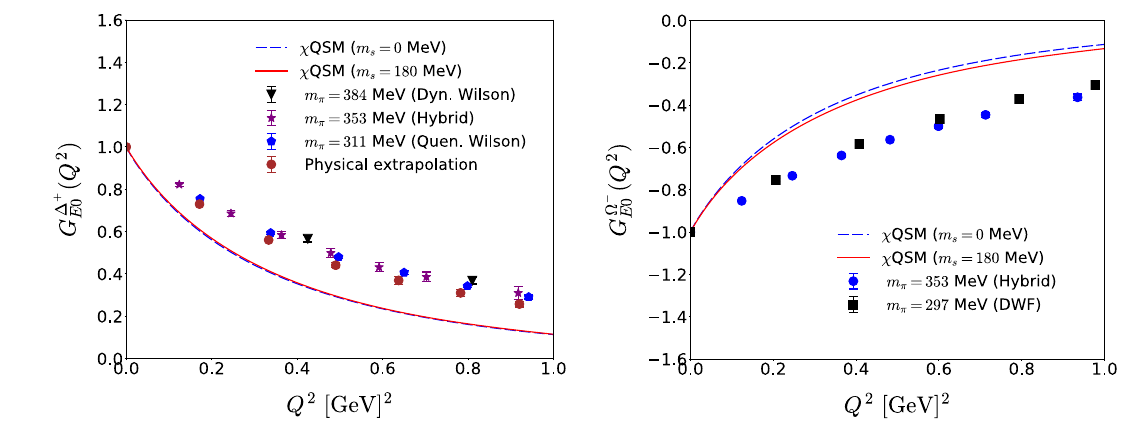
Fig. 7 Effects of the explicit flavor SU(3) symmetry breaking on the electric monopole form factors of the (cid:2) + isobar and (cid:5) − in the left and right panels, respectively. The dashed curves depict the E 0 form fac-